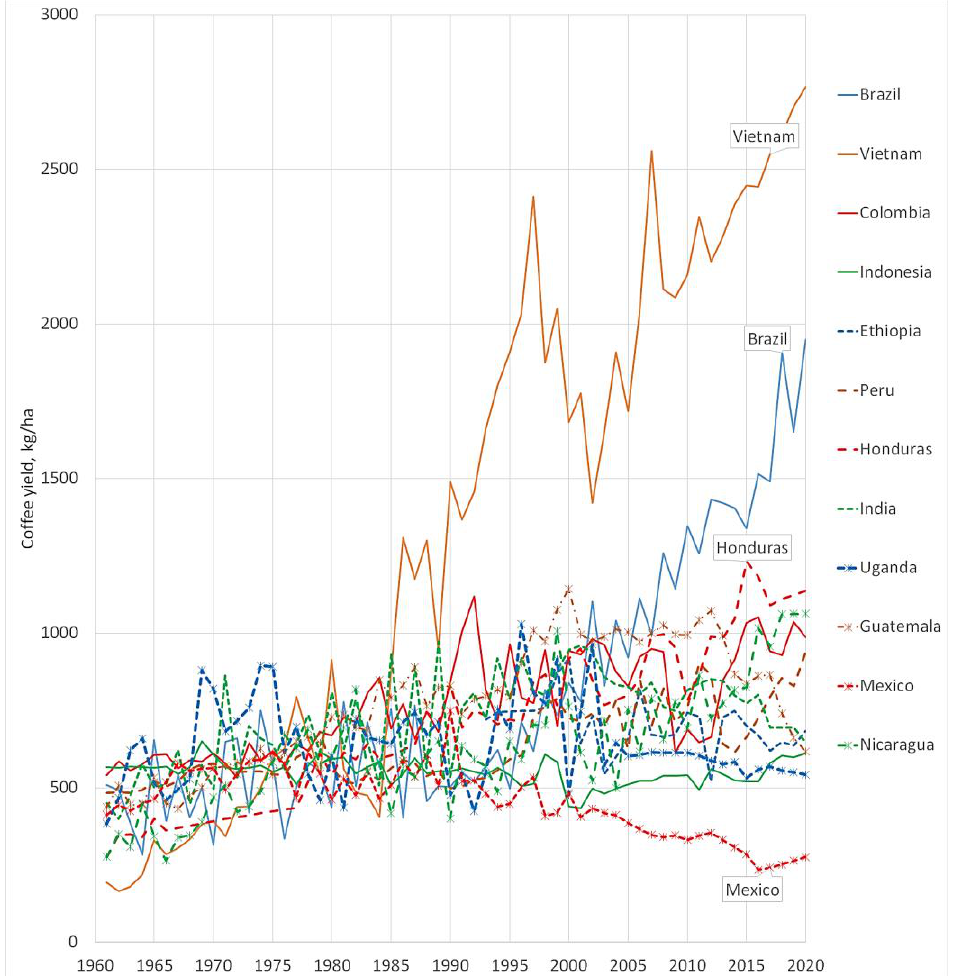
Figure 3. Coffee (green beans) yield tendencies from 1961 to 2020 (kg/ha). Source: authors’ own construction based on data from [50].